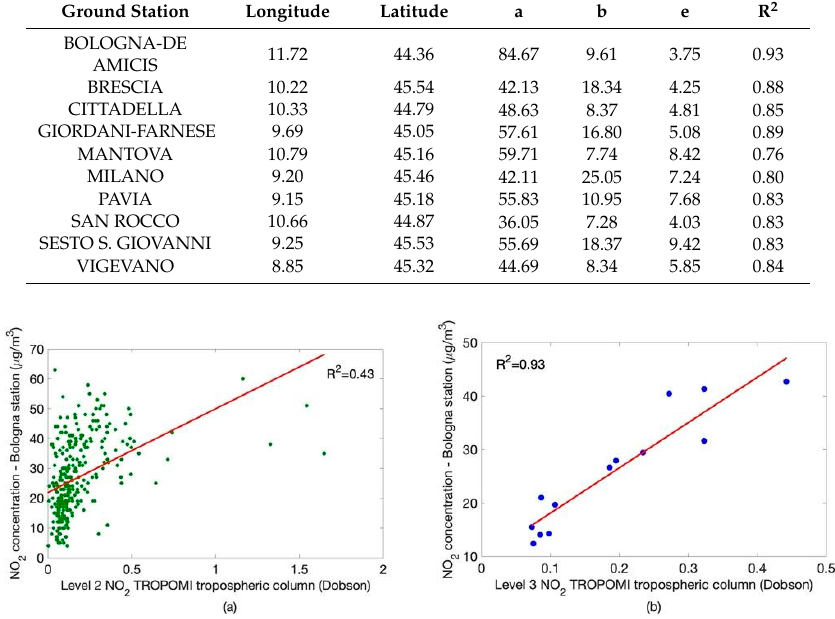
Figure 7. Scatter plot of NO 2 observations for the Bologna-De Amicis station. Before ( a ) and after ( b ) data kriging. The analysis refers to the period of May 2018 – May 2019.